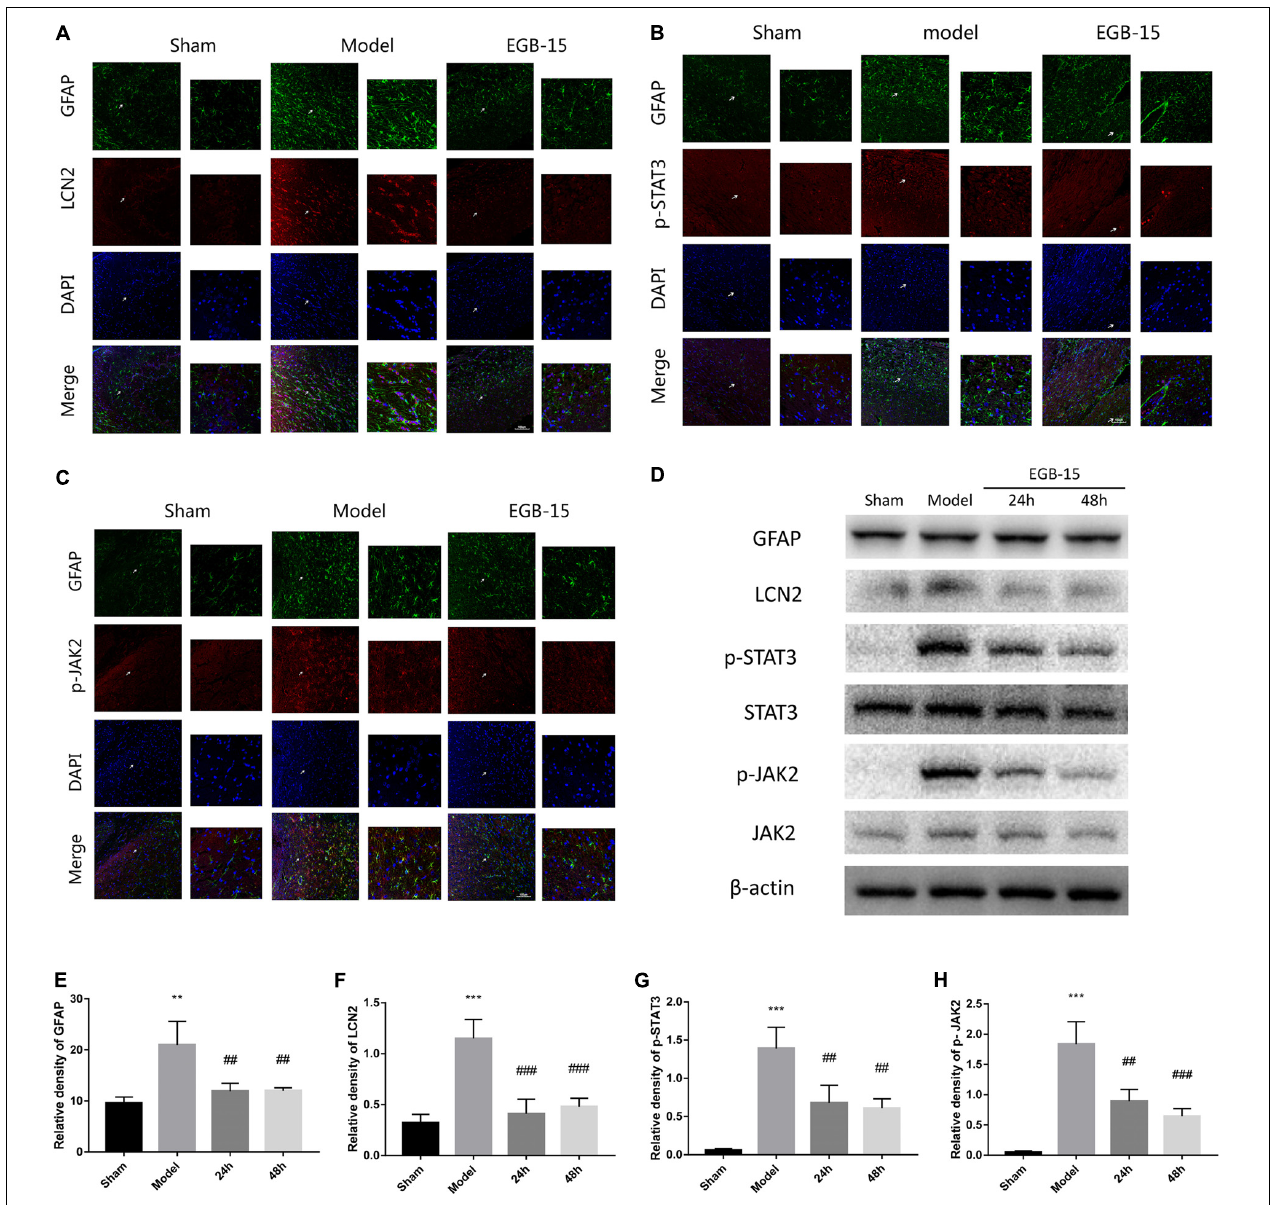
FIGURE 4 | Effects of EGB on the activation of astrocytes and the expression of LCN2, p-JAK2, p-STAT3, in cerebral ischemia rats. (A–C) Double-immunofluorescence staining for astrocytic LCN2, p-STAT3, p-JAK2, and GFAP expression in the ischemic penumbra area after cerebral ischemia. The cells indicated with an arrow were magnified. Scale bar = 20 µ m. (D–H) Western blots and quantitative analysis of GFAP, LCN2, p-JAK2, and p-STAT3 expression are expressed as mean ± SEM ( n = 4). ∗ p < 0.05, ∗∗ p < 0.01 and ∗∗∗ p < 0.001 vs. sham group; # p < 0.05, ## p < 0.01 and ### p < 0.001 vs. model